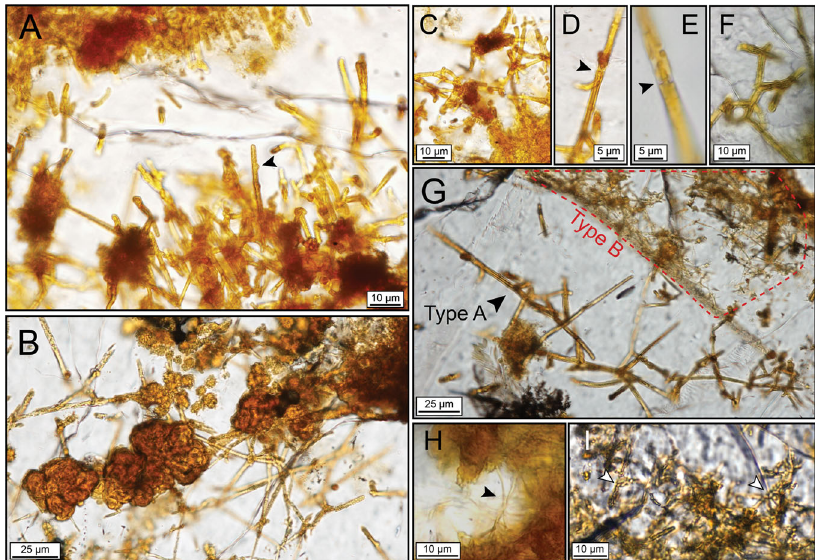
Fig. 2 Filamentous structures preserved within the serpentine-hosted aragonite vein shown via transmitted light microscopy. A Type A fi laments anchored to the iron-encrusted polygonal zone wall. Filaments here display rounded terminal ends and occasional budding along stalks (black arrow). B Type A fi laments among clusters of laminated and fl occulent iron oxide precipitates. C Type A fi lament interspersed among iron oxides. D Type A fi lament showing branching at septate division. E Type A fi lament displaying narrow channel-like structure along septal division. F Example of potential anastomosing among Type A fi laments. G Branching Type A fi laments adjacent to a cluster of Type B fi laments (outlined in red), indicating relative size difference between the two morphotypes. H Thin Type B fi laments spanning across iron oxide precipitates. I Dense cluster of Type B fi laments with some specimens resembling twisted stalks (white arrows). n = 45; Fig. 2H, I, and S4). The maximum length of Type B fi laments observed was 11.2 µm, although most fi lament termina- tions are visibly obscured by surrounding iron oxides or are cut off by the limited thin sectioned volume. Type B fi laments do not appear to have septate partitions, instead occurring as continuous fi laments. Like the Type A fi laments, most Type B fi laments were observed as tightly intertwined bundles among clusters of iron oxide precipitates fl oating within the carbonate matrix and along the iron-encrusted polygonal zone walls (Fig. 2H and I).